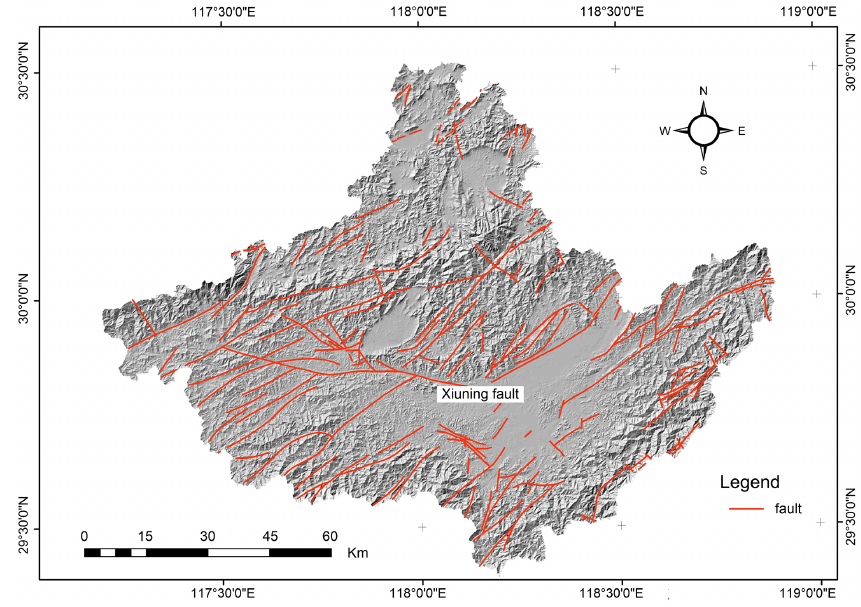
Figure 2. Faults distribution of the Huangshan region with a digital elevation model (DEM)